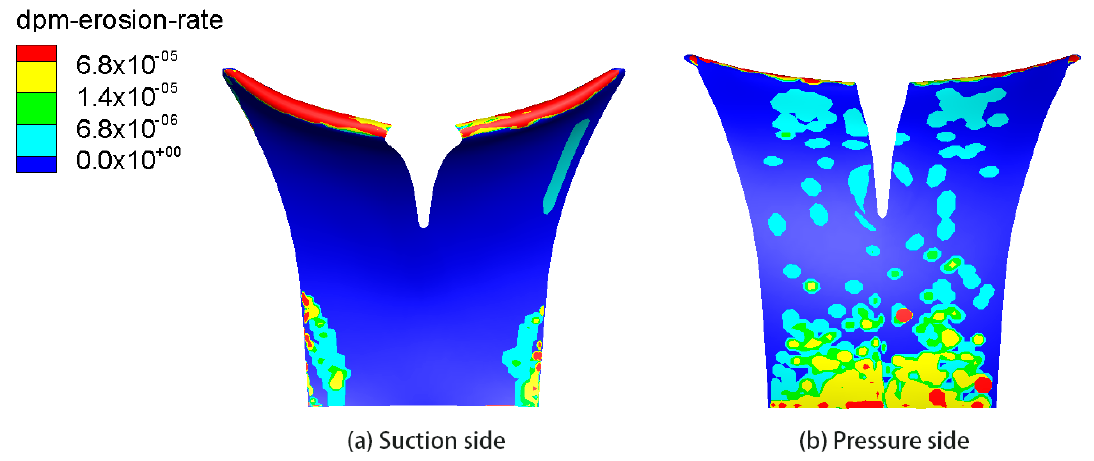
Figure 15. Silt erosion on blade surface (units: μ m/s, silt concentration: 6.5 kg/m 3 ).